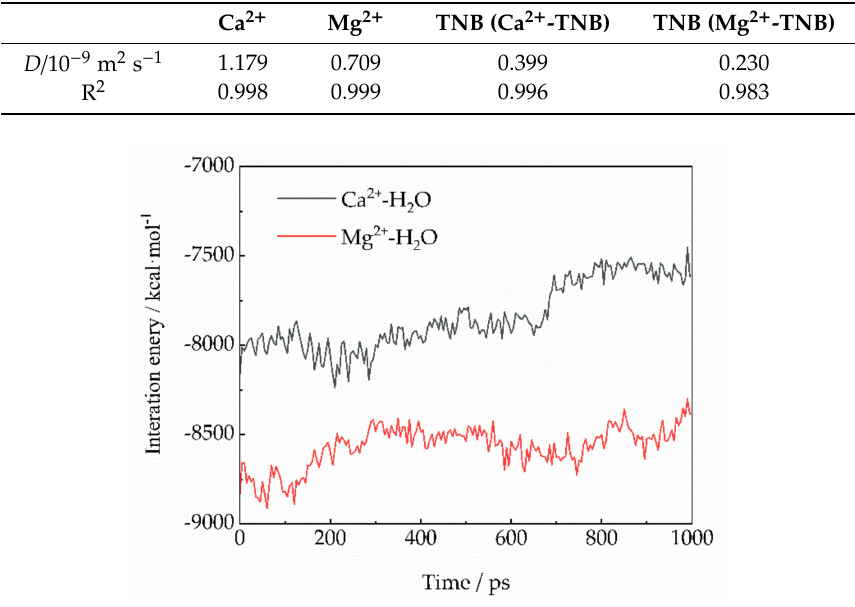
Figure 4. Interaction energy between ions and water